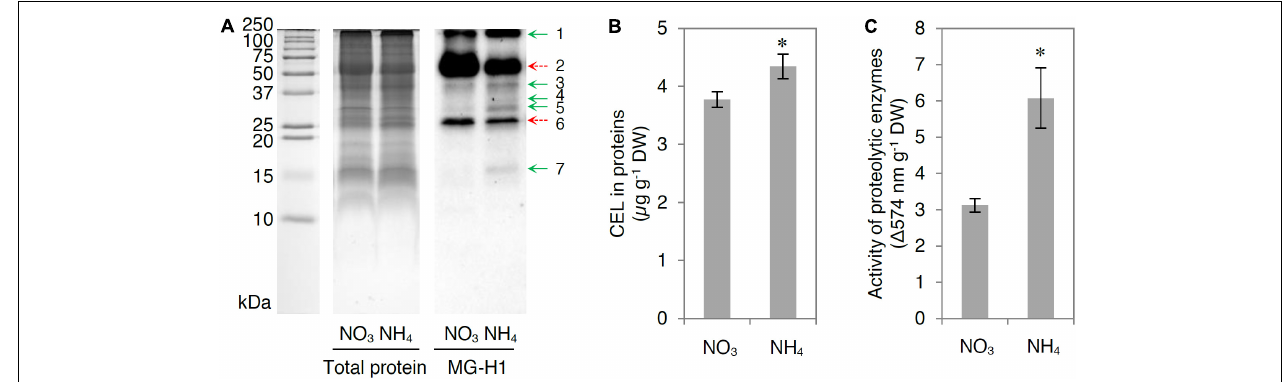
FIGURE 7 | Influence of ammonium (NH 4 + ) nutrition on methylglyoxal (MG)-derived advanced glycation end products formation and proteolysis. (A) Total protein stained gel and MG-derived hydroimidazolone 1 (MG-H1) levels in proteins; (B) concentration of N-epsilon-(carboxyethyl)lysine (CEL) in proteins; and (C) activity of proteolytic enzymes in leaf tissue of nitrate (NO 3 − )-grown and NH 4 + -grown plants. Total leaf extract proteins (25 µ g for blotting or 60 µ g for protein staining) were separated by sodium dodecyl sulfate-polyacrylamide gel electrophoresis. For MG-H1 detection, proteins were electroblotted on a polyvinylidene difluoride membrane and probed with a monoclonal antibody. Representative results are shown. The difference in the levels of MG-H1 between NH 4 + -grown and NO 3 − -grown plants is indicated by arrows; increased levels are marked with green arrows, whereas decreased levels are marked with dashed red arrows. Values are the mean ± standard deviation (SD) of 3 biological and 1–3 technical replicates. Significant differences ( P ≤ 0.05) between NO 3 − -grown and NH 4 + -grown plants are indicated by an asterisk ( ∗